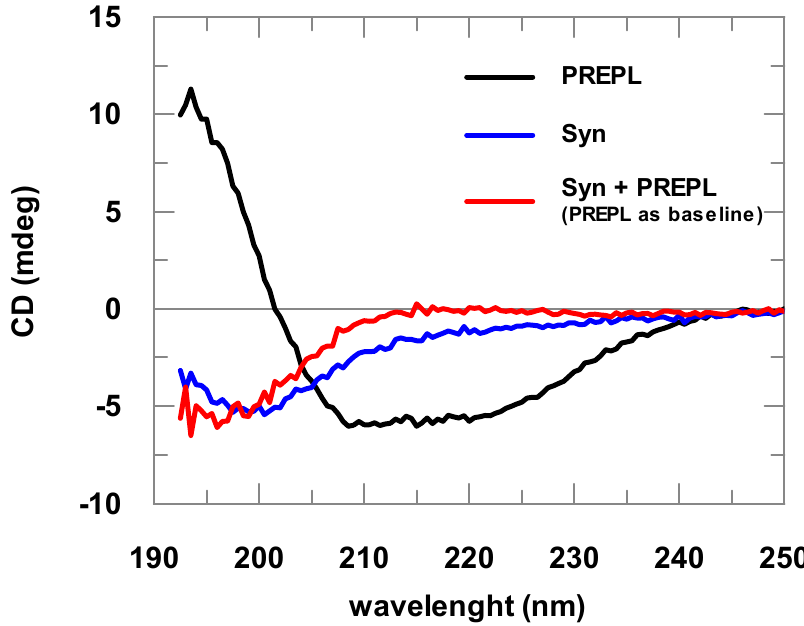
Figure 2. Far ‐ ultraviolet (UV) circular dichroism (CD) spectra of PREPL (2 μ M), α‐ synuclein ( α‐ Syn; 8 μ M), and PREPL (2 μ M) mixed with α‐ Syn (8 μ M). The different α‐ Syn spectra obtained in the absence of PREPL (blue line) and in the presence of PREPL (red line) show the interaction between these proteins, where a conformational change is coupled with α‐ Syn binding to PREPL.